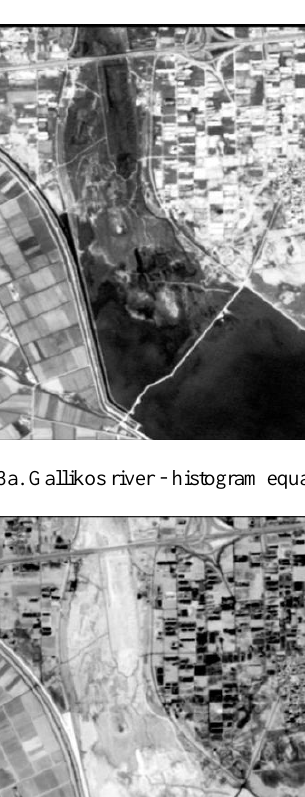
Figure 3. Gallikos river estuaries